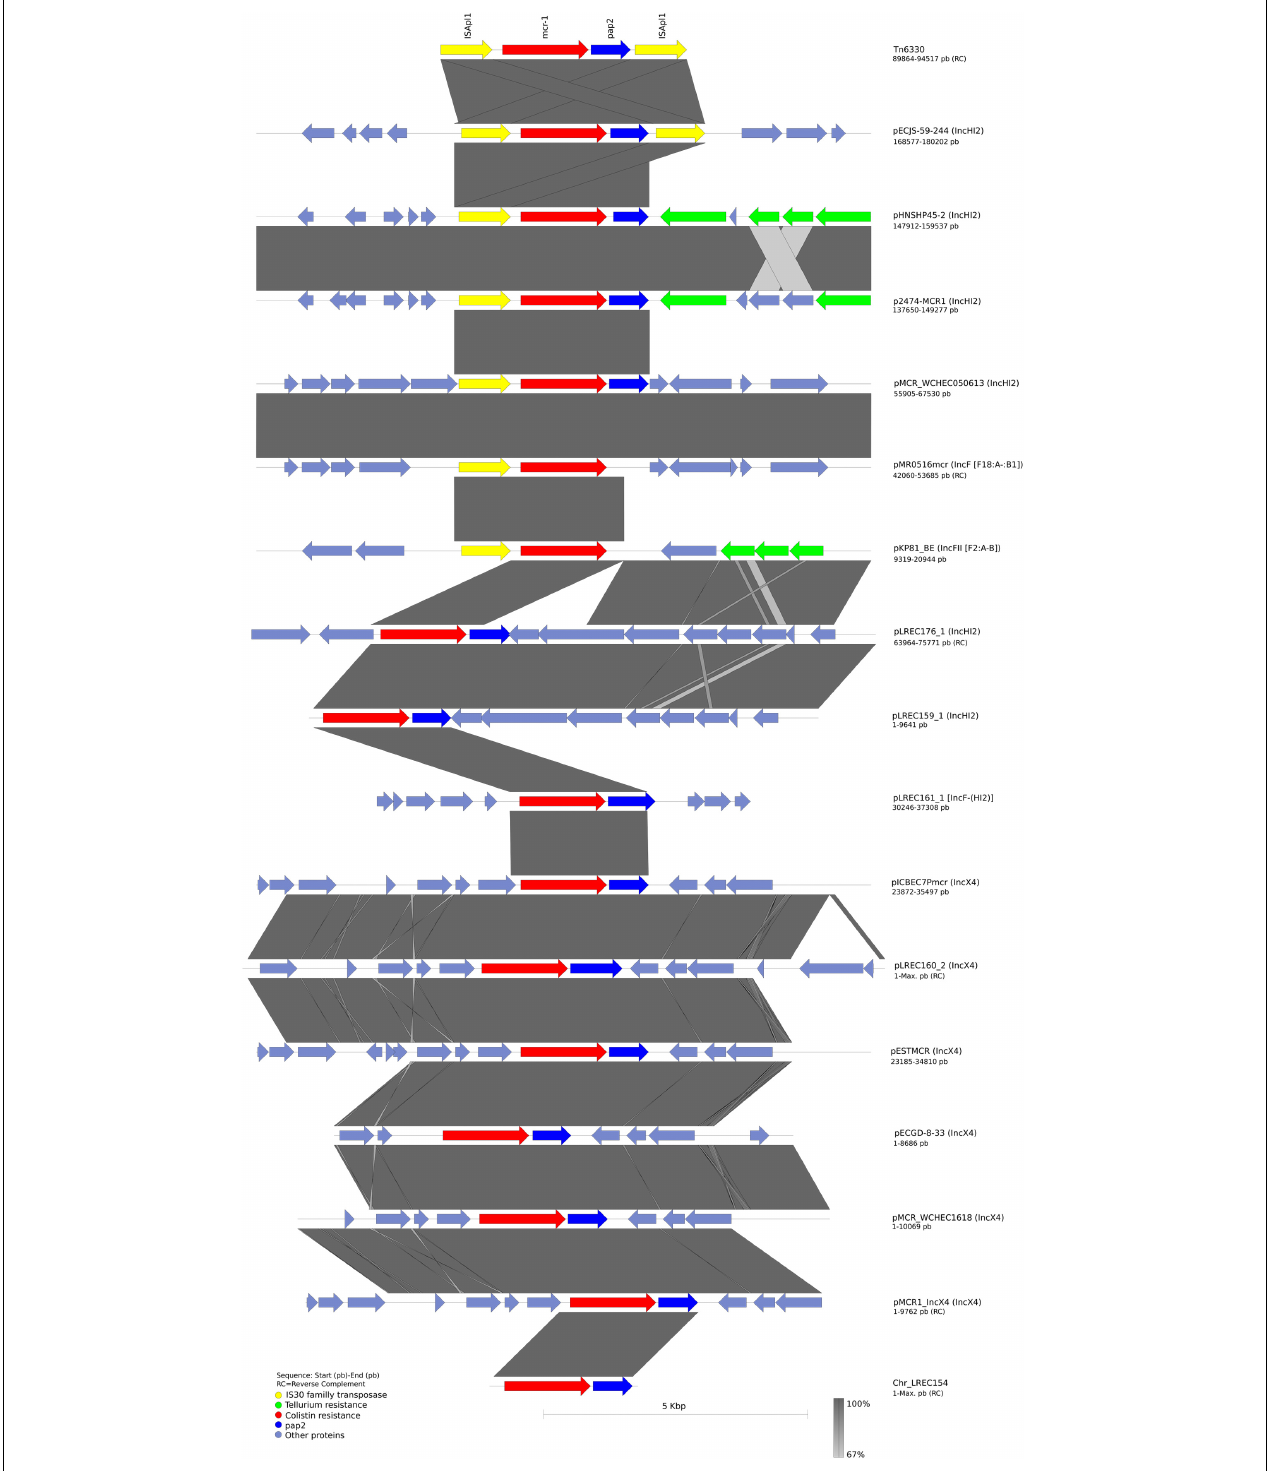
FIGURE 5 | Comparison of the homologous region of the composite transposon Tn6330 (CP029493.1) containing mcr -1 gene with our sequences and other frequently used reference sequences analyzed in this article. Open arrows represent coding sequences (green for tellurium resistance, yellow for IS Apl 1, red for mcr -1, and blue for pap 2) and indicate direction of transcription. The arrow size is proportional to the gene length. The shadow parallelograms denote genetic regions that exhibit sequence homology among different segments. Light shadow denotes regions with a lower level of sequence identity (99%) by BLAST. The image was generated using EasyFig (default